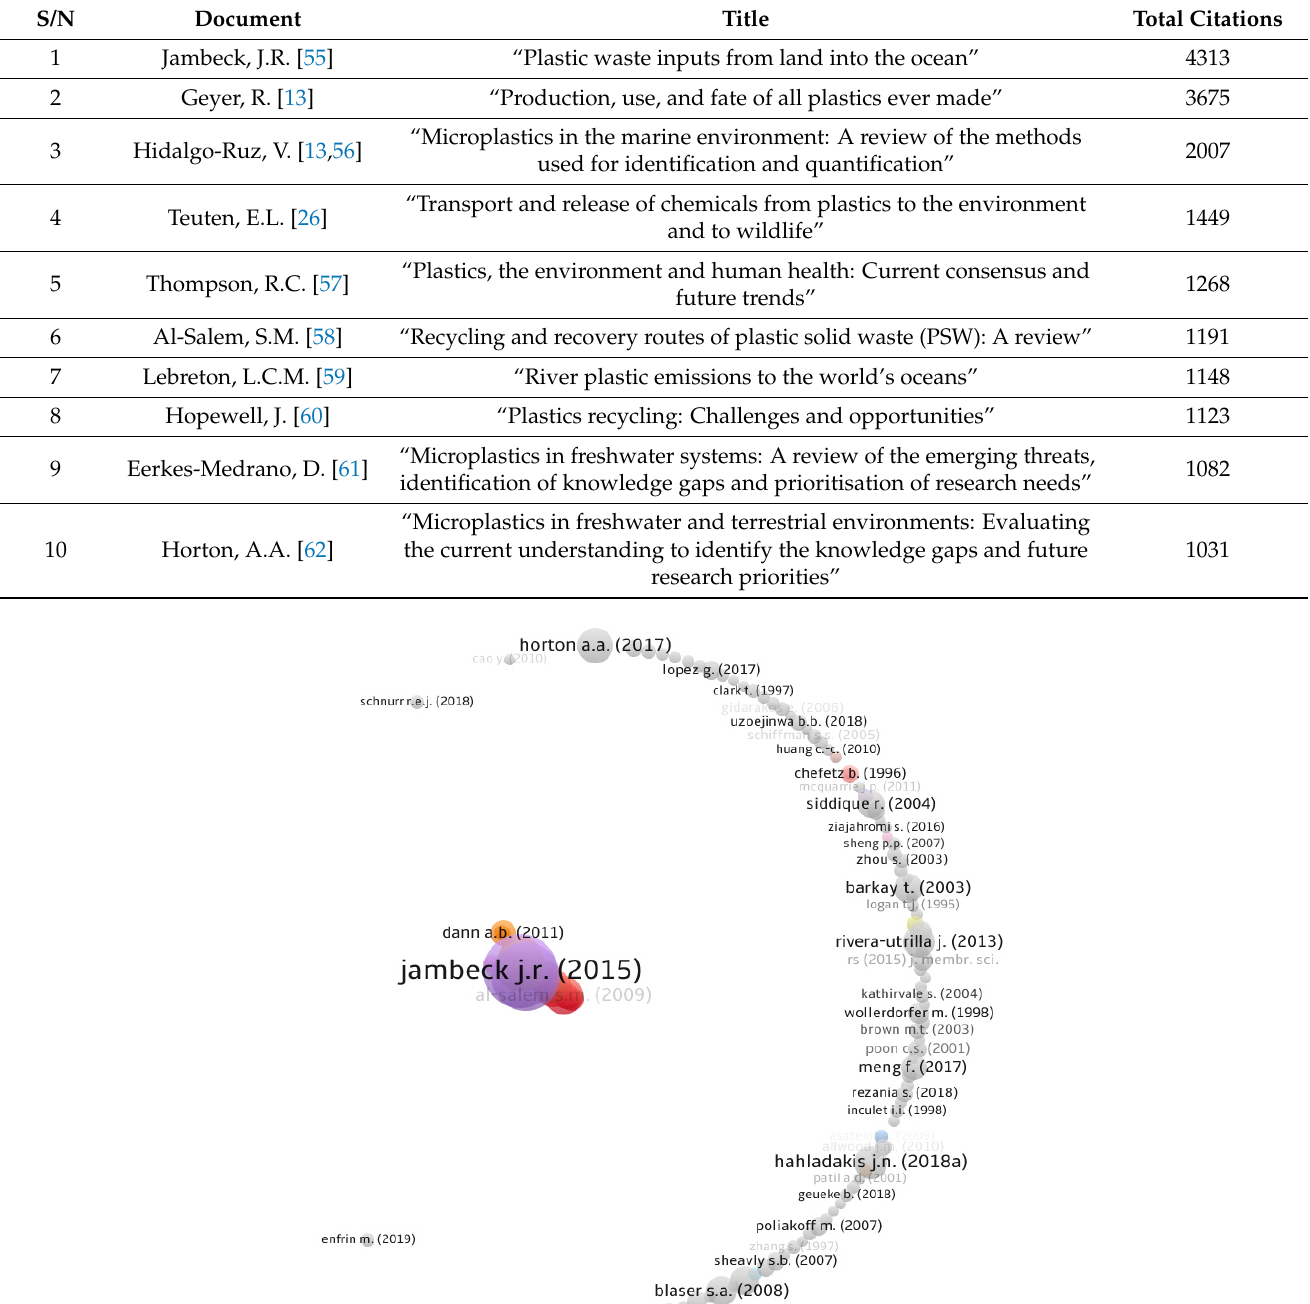
Table 4. Leading 10 most cited articles up through 2021 in the related study area.